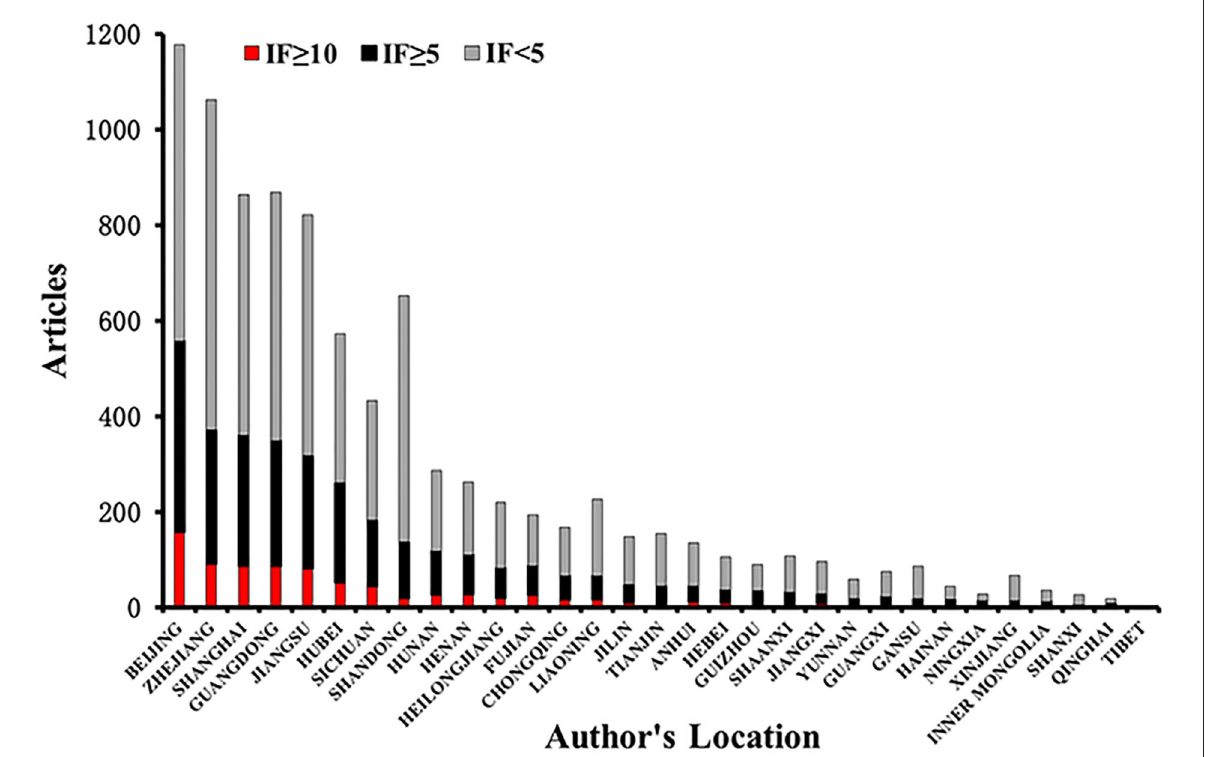
FIGURE3 Geographical distribution of the publications by Chinese authors. The X-axis were the provinces/municipalities, where the hospitals of the first or corresponding authors of the publications were located. The Y-axis represented the number of their publications from 2001 to 2020, which were stratified by the impact factor (IF) of the journals publishing these articles, marked on red (IF ≥ 10), black (IF < 5), and gray (IF < 5) as well. A disequilibrium analysis of the distribution of impactful publications among regions from 2001 to 2020 were performed by using Fisher’s exact probability analysis, and the result suggested that P < 0.001, which indicated the number of publications in different impact factor groups varied by